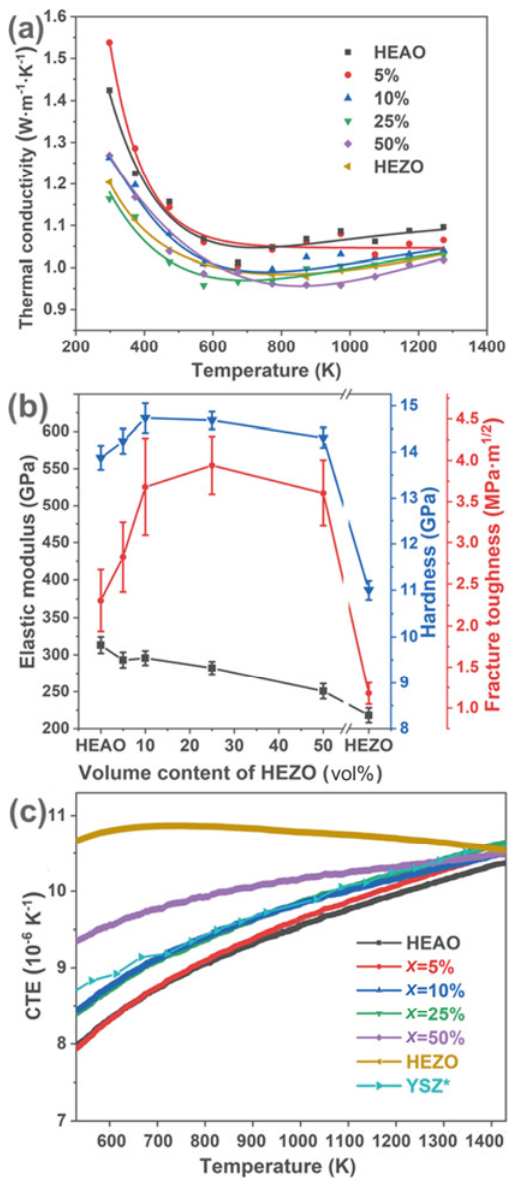
Fig. 5 Thermal physical and mechanical properties of HEAO– x HEZO ceramic composites. (a) Thermal conductivities, (b) mechanical properties, and (c) CTEs of HEAO– x HEZO